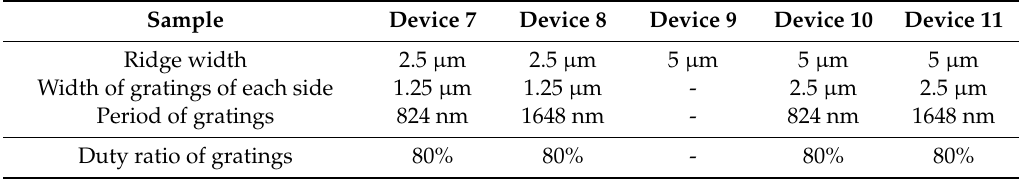
Table 2. Structure parameters of the fabricated DFB LDs of sidewall gratings and F–P LDs.